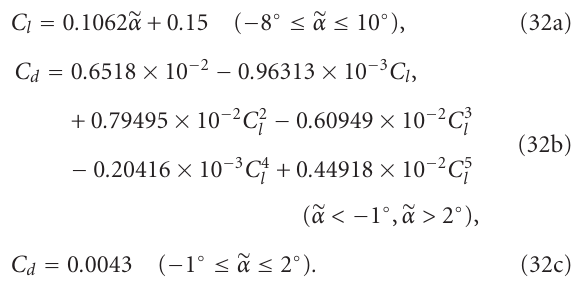
Figure 4: A comparison of distorted flow propagation between the results of Ng et al. [12] and those of Kim et al. [6].